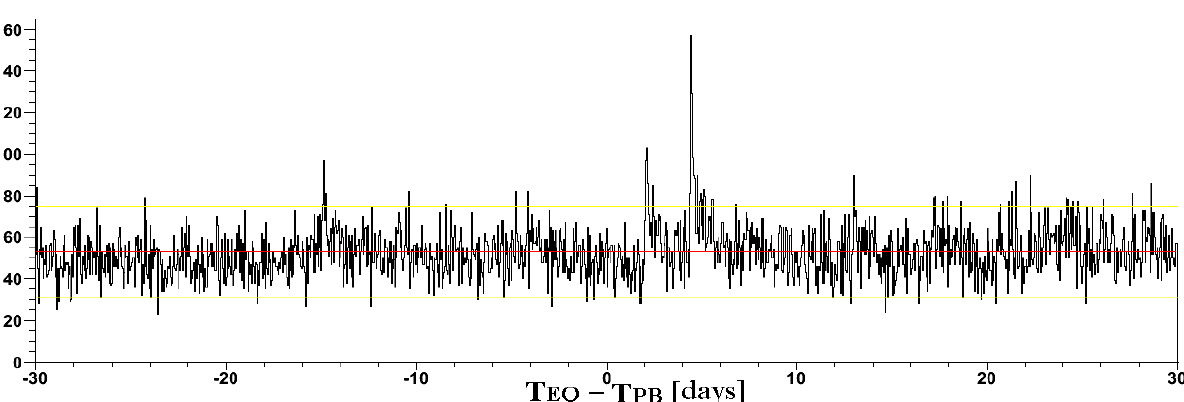
Figure 7. Correlation time within 30 days of global EQ activity and NOAA 15 PBs. EQs and PBs were selected from an 11 year database, from July 1998 to July 2009, with the condition |L − L | < 0.1. In this plot, EQ epicenters were projected at 1,400 km and EQ PB mirror altitudes PBs were less than 100 km. The red line shows the average and the yellow lines show the 3 sigmas significance. Binning was 1